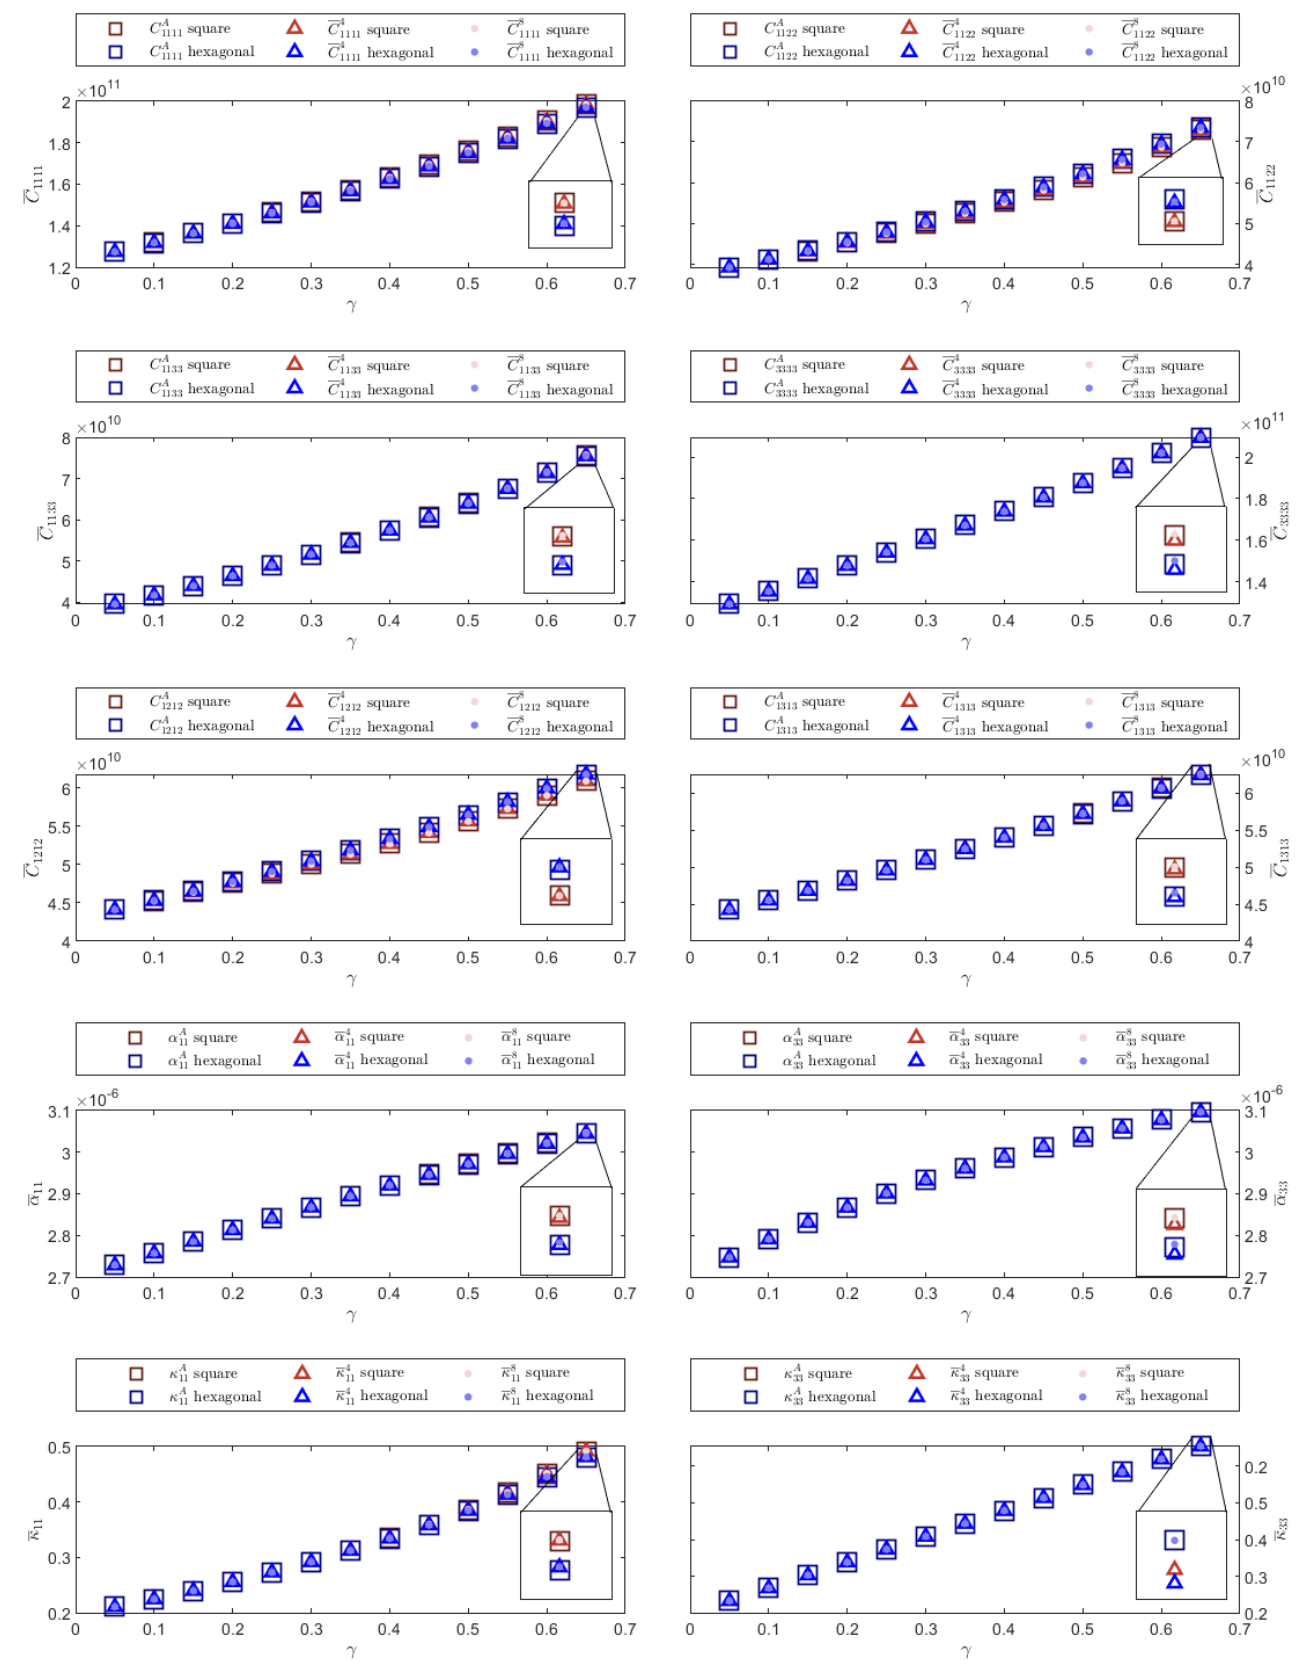
Figure 4. Effective properties for Nicalon/BMAS composite material for square and hexagonal